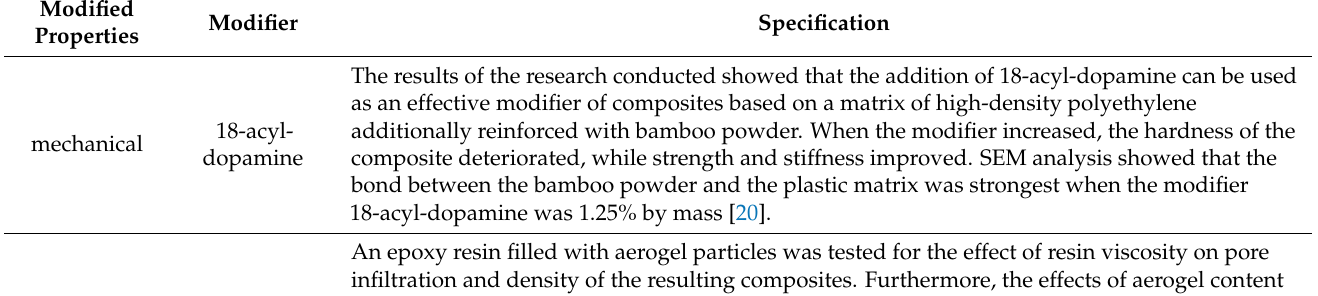
Table 1. Examples of application of physical modifiers affecting the change of selected properties of composites.